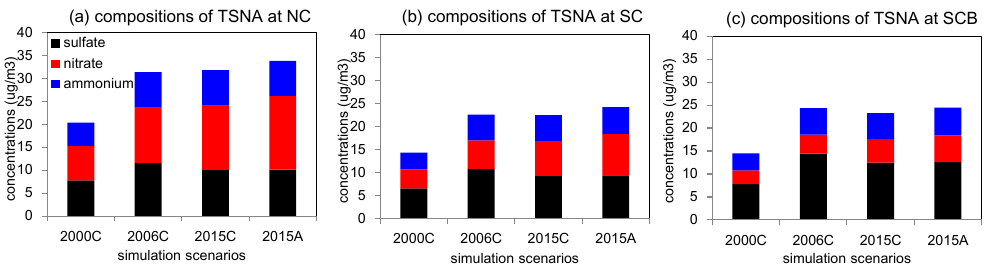
Fig. 13. Simulated composition and concentration changes of SNA aerosols from 2000 to 2015 over (a) NC, (b) SC and (c) SCB. Four simulation cases are compared: 2000C, 2006C, 2015C, and